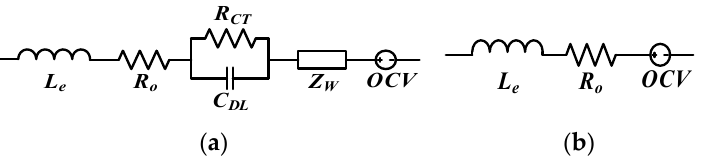
Figure 1. Equivalent circuit of electrical battery model: ( a ) Full battery impedance model; ( b ) Simplified battery impedance model.